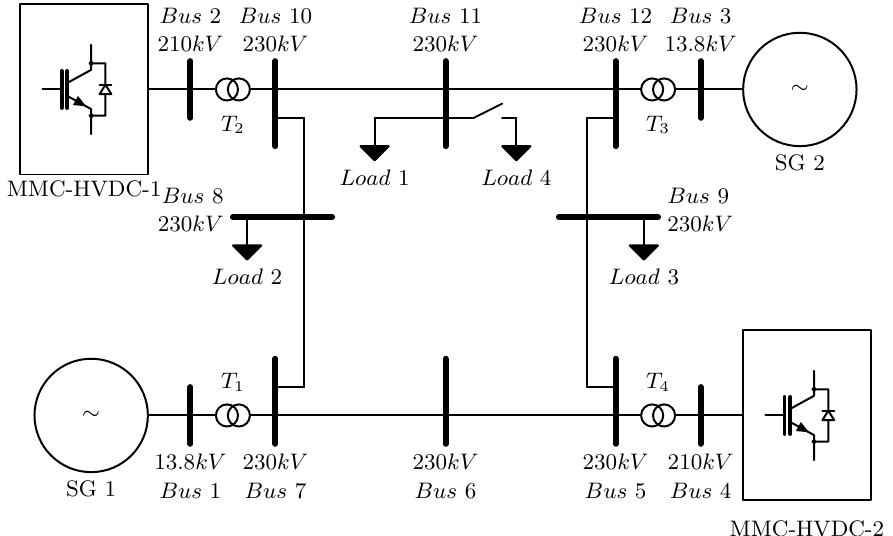
Figure 7. 12 bus electric grid used as the test system for the